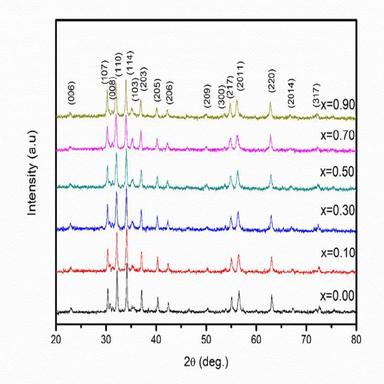
XRD patterns of the BaZnxZrxFe(12-2x)O19 (x=0, 0.1, 0.3, 0.5, 0.7, and 0.9) recorded at room temperature